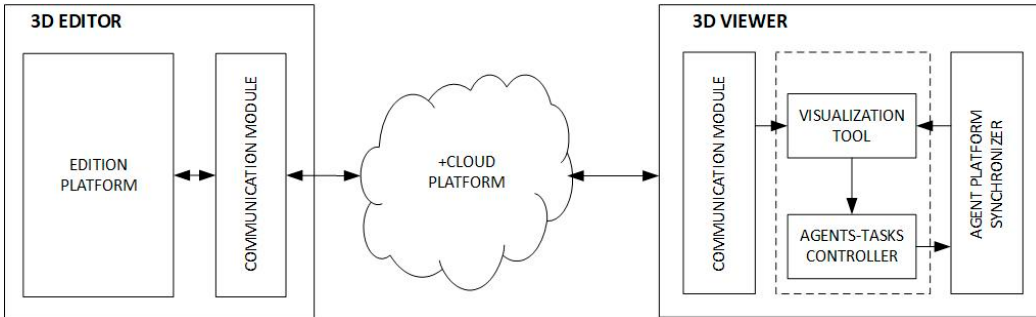
Figure 4. The 3D environment modules.